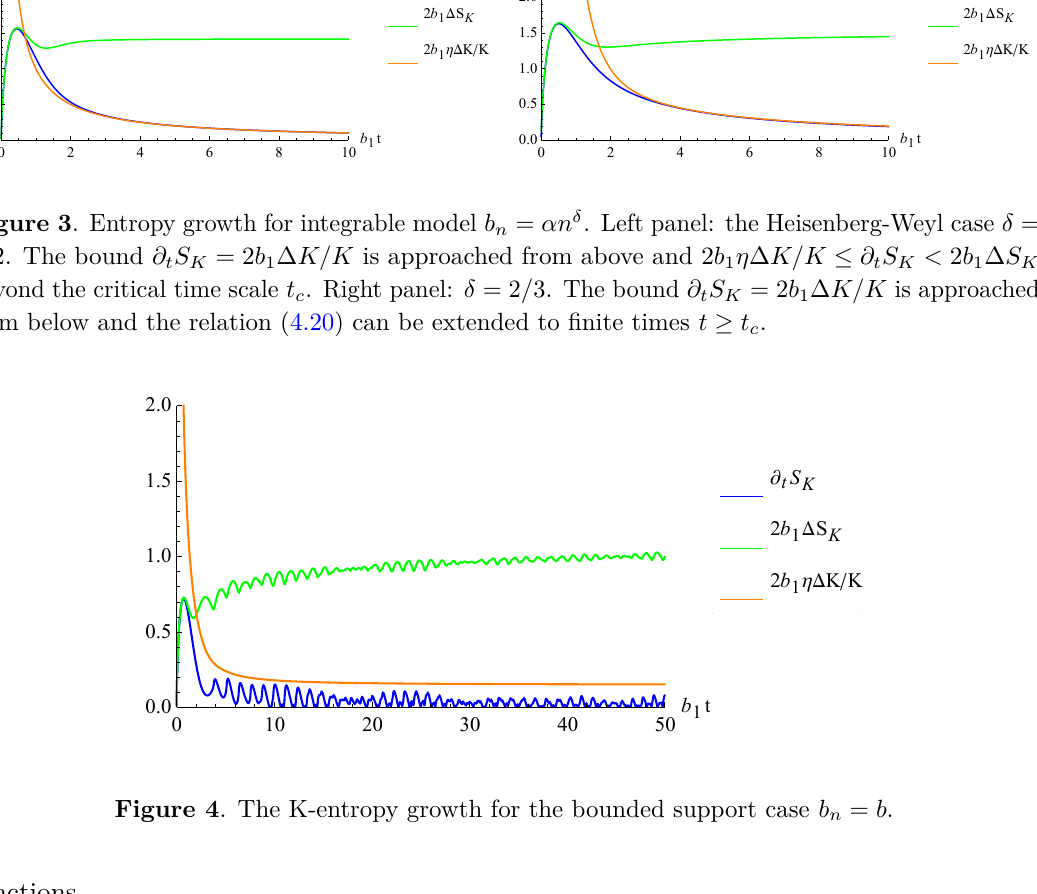
Figure 4 . The K-entropy growth for the bounded support case b n = b